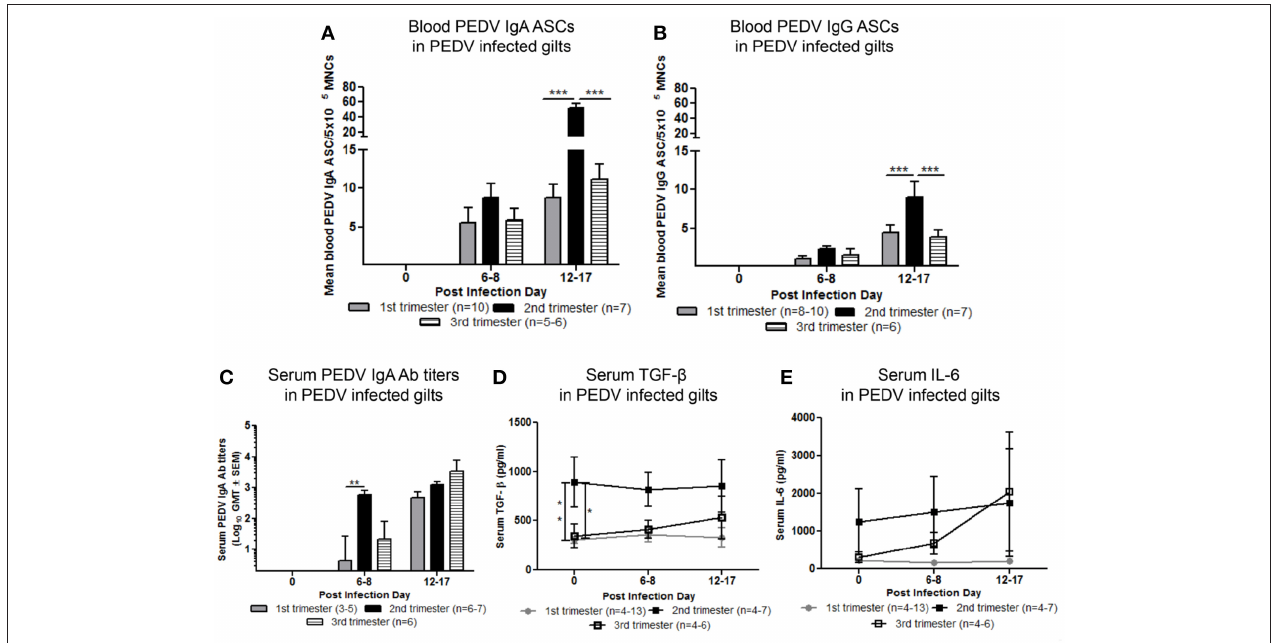
FIGURE 4 | Second trimester gilts had significantly increased circulating PEDV specific IgA and IgG antibody secreting cells (ASCs) at post infection day (PID) 12–17, PEDV specific IgA antibodies (Abs) at PID 6–8 and concentrations of transforming growth factor (TGF)- β at PID 0 compared with first and third trimester gilts. (A) Peripheral blood mononuclear cells (PBMCs) were isolated and added to PEDV ELISPOT plates to determine the PEDV specific IgA and (B) IgG ASCs. (C) Serum PEDV IgA Ab titers and cytokine concentrations (pg/ml) of (D) TGF- β and (E) interleukin (IL)-6 were determined by ELISA. Gilts were sampled at PID 0, 6–8, and 12–17. Asterisks indicate significant differences among treatment groups at the same time point (mean ± SEM). Statistical analysis was performed using the two-way ANOVA with repeated measures and Bonferroni’s correction for multiple comparisons. * P < 0.05, ** P < 0.01, *** P <